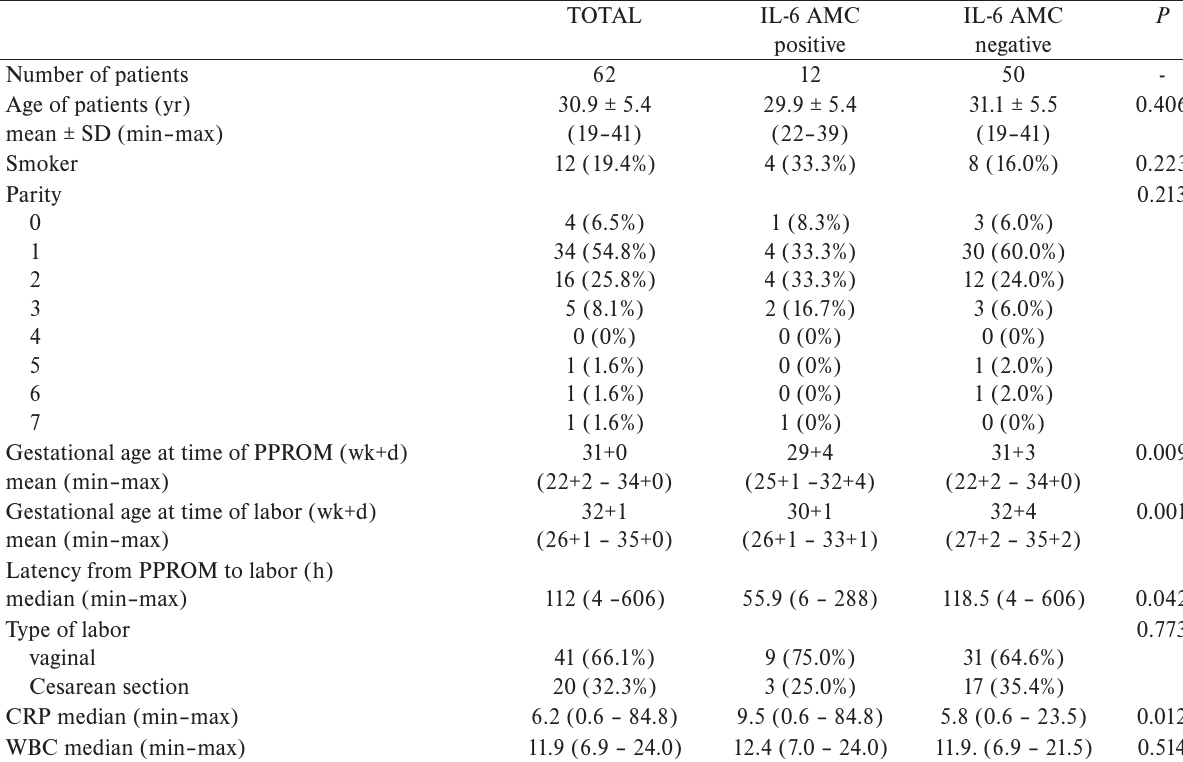
Table 1. Basic characteristics of women with PPROM. The data in the table are presented as the number (%) or mean / median with (minimum – maximum) values.